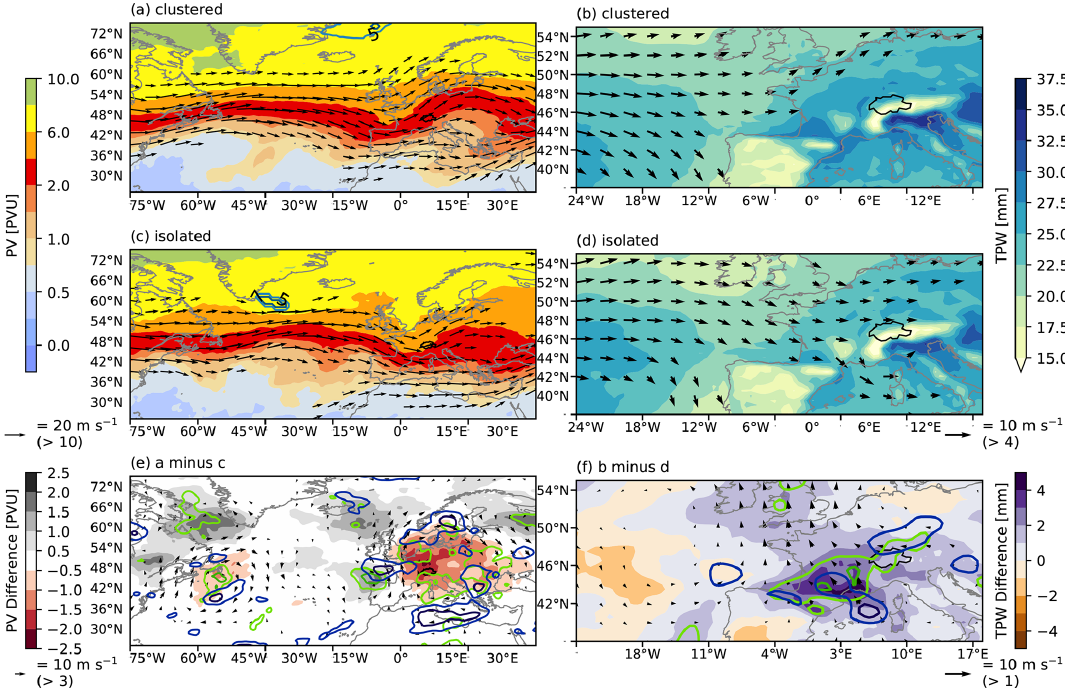
Figure 9. Weather patterns during clustered and isolated hail days south of the Alps. (a) PV at 335K, winds at 250hPa, and blocking frequency on clustered hail days; (b) TPW and wind at 850hPa on clustered hail days; (c, d) same as panels (a) and (b) but for isolated hail days; (e, f) difference of clustered minus isolated weather patterns. In panel (e) the significances of differences for PV and wind speeds are shown in green and blue contour lines and in panel (f) for TPW and wind speeds. See Fig. 5 for more